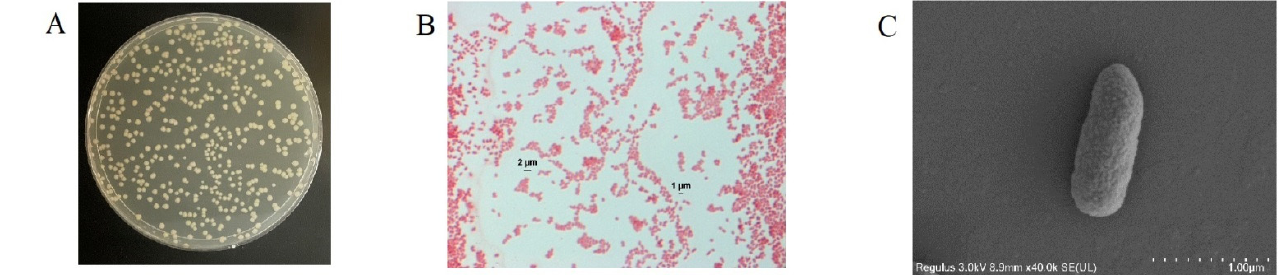
Figure 1. Morphological characteristics of Pseudomonas putida HSM-C2. ( A ) colony morphology, ( B ) gram staining result(10 × 100), ( C ) SEM result(the magnification is 40,000×).